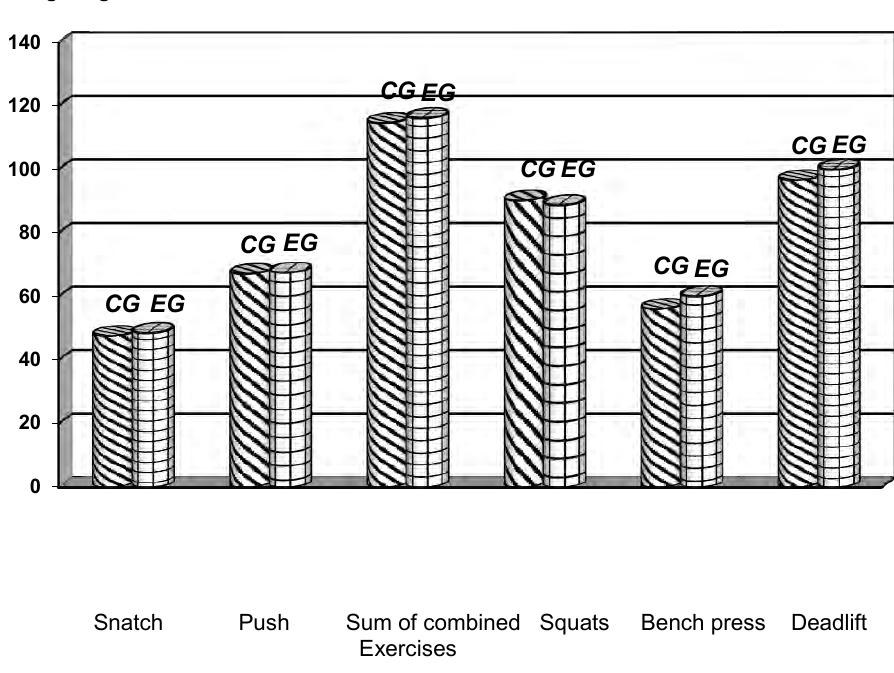
Fig.1. Comparative analysis of special exercises’ fulfillment in control (CG) and experimental (EG) groups at the beginning of preparatory period